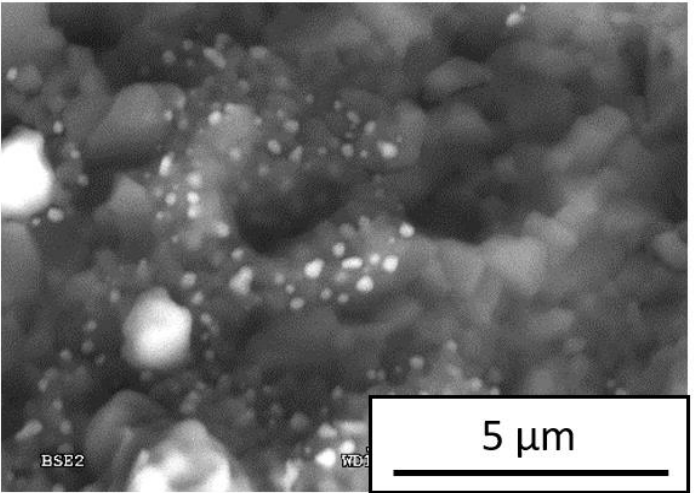
Figure 4. SEM images of ceramic–metal composites microstructure represent type IA from Table 1; Al 2 O 3 -Ni, Ni particles (white) located in ceramic matrix. Source: results obtained under supervision of K. Konopka.